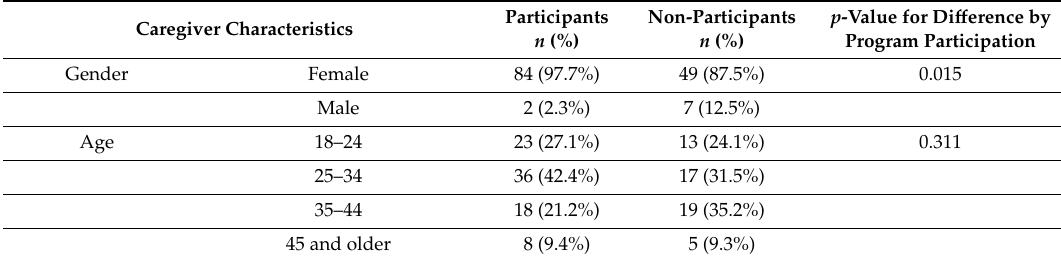
Table 2. Di ff erences in caregiver and child characteristics between fruit and vegetable prescription program participants versus